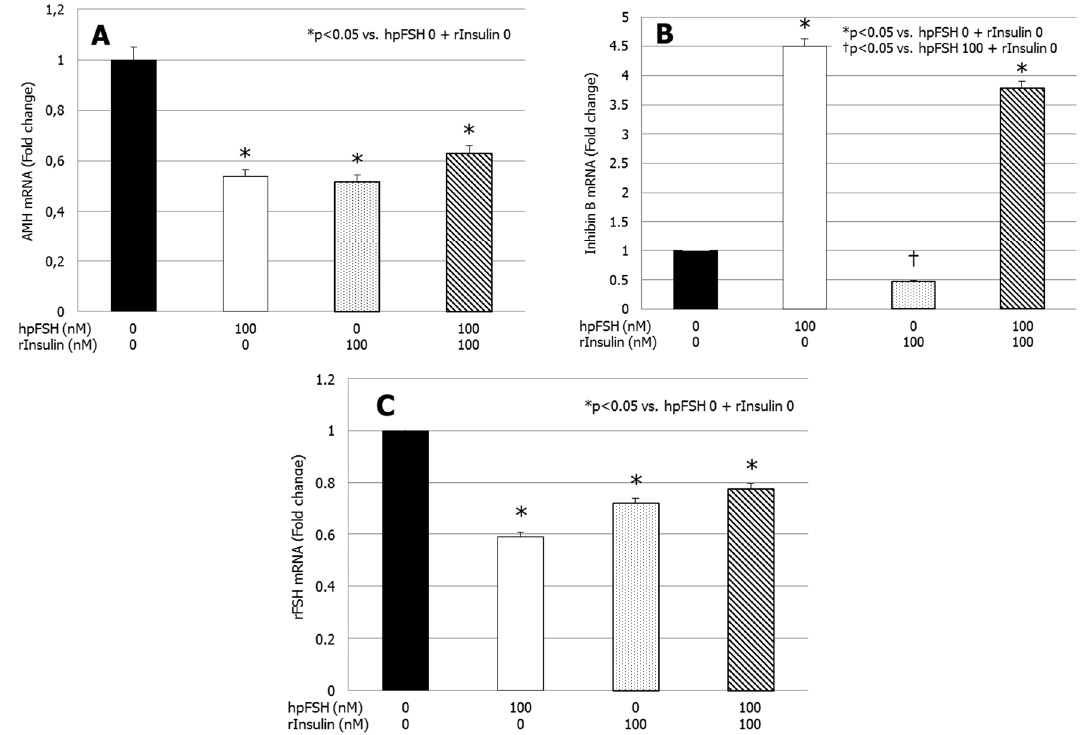
Figure 1. RT-PCR analysis of ( A ) anti-Müllerian hormone ( AMH ), ( B ) inhibin B and ( C ) FSHR gene expression. Data represent the mean ± SEM of three independent experiments, each performed in triplicate. * p < 0.05 vs. control; † p < 0.05 vs. highly purified urofollitropin (hpFSH) (one-way ANOVA).